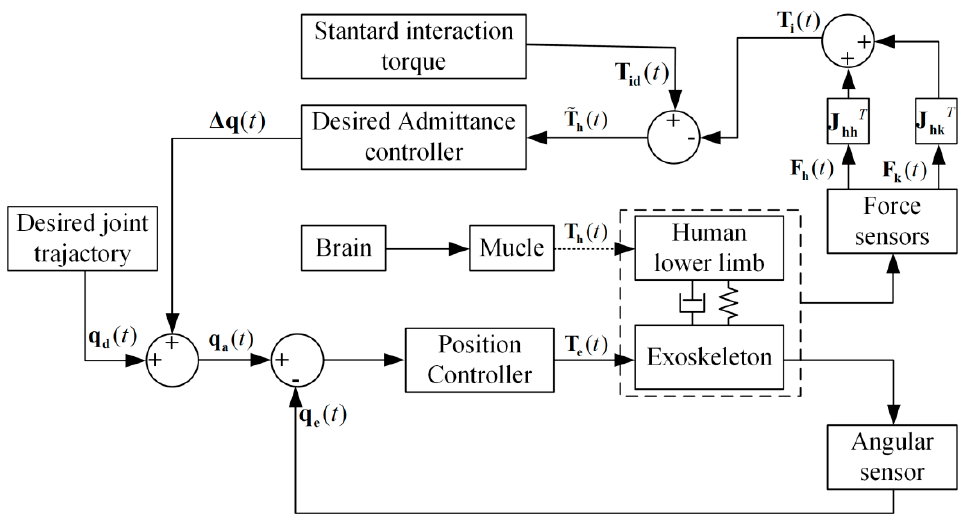
Figure 6. Admittance control structure of the human exoskeleton coupling system.